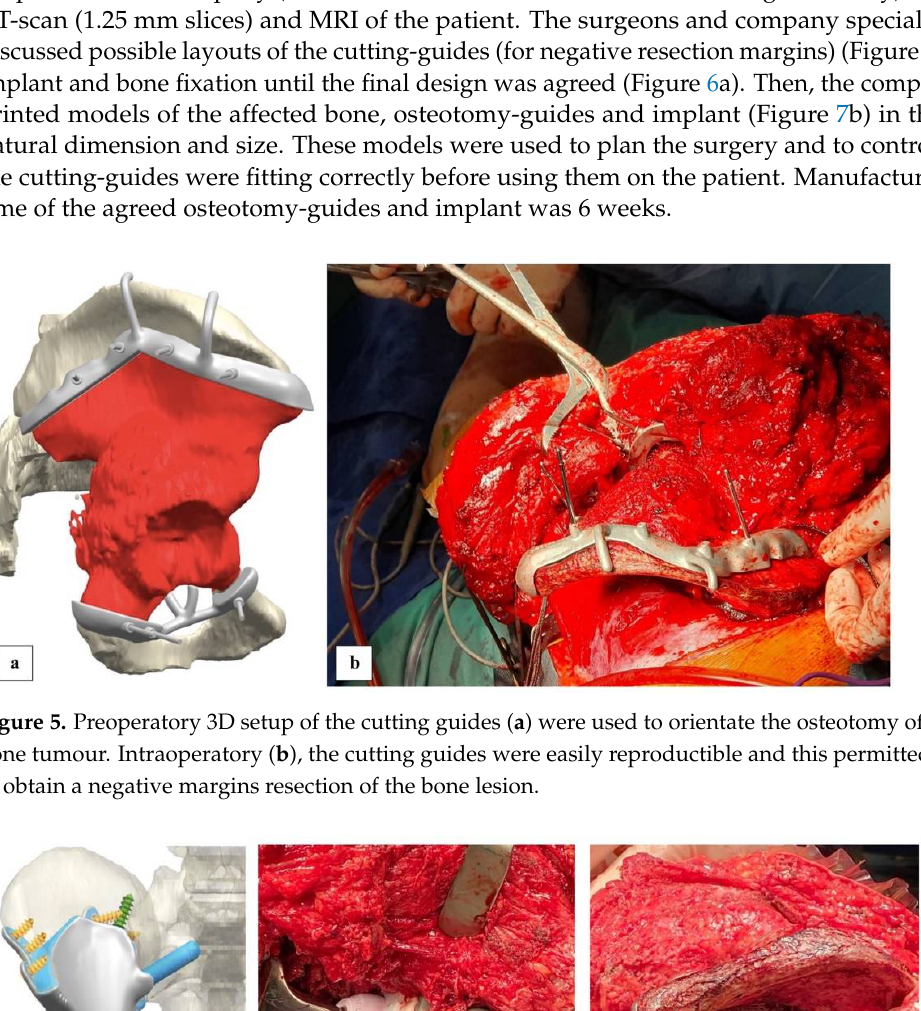
Figure 4. MRI axial ( a , c ) and coronal ( b ) views. T2 FS ( a ), STIR ( b ) and T1+k ( c ) sequences. MRI reveals an intraosseous heterogeneous mass. No adjacent bone marrow or soft tissue oedema. Rel- atively important cystic component with fluid-fluid level (arrows). Small solid components with moderate contrast enhancement (arrowheads).